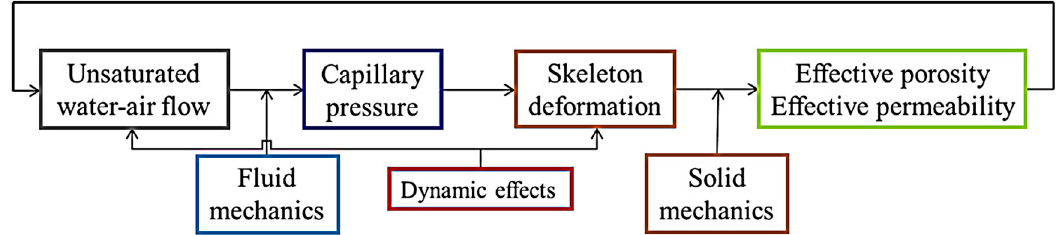
Figure 11. The hydro-mechanical coupling process considers dynamic effects [257].